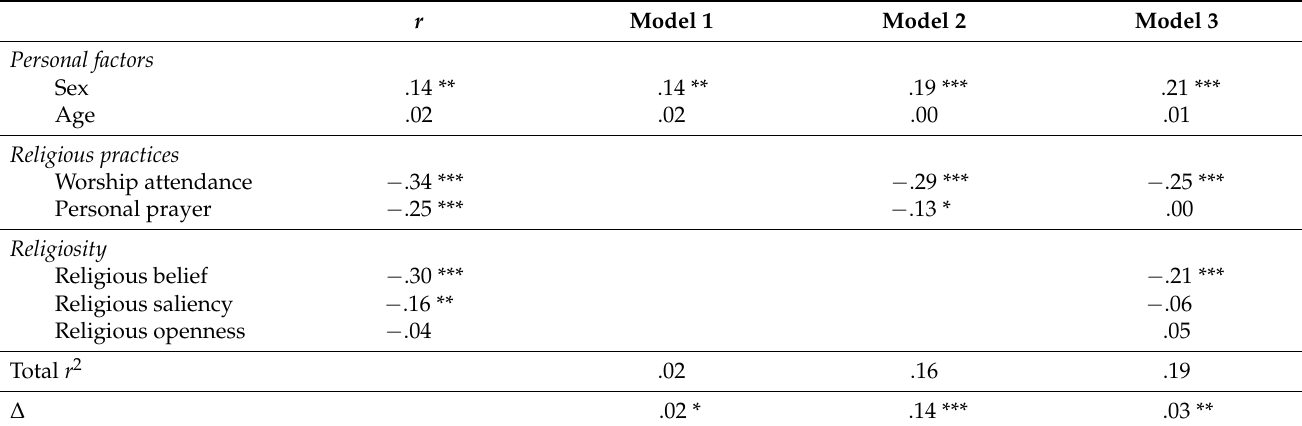
Table 6. Regression models on Scale of Attitude toward Euthanasia and Abortion